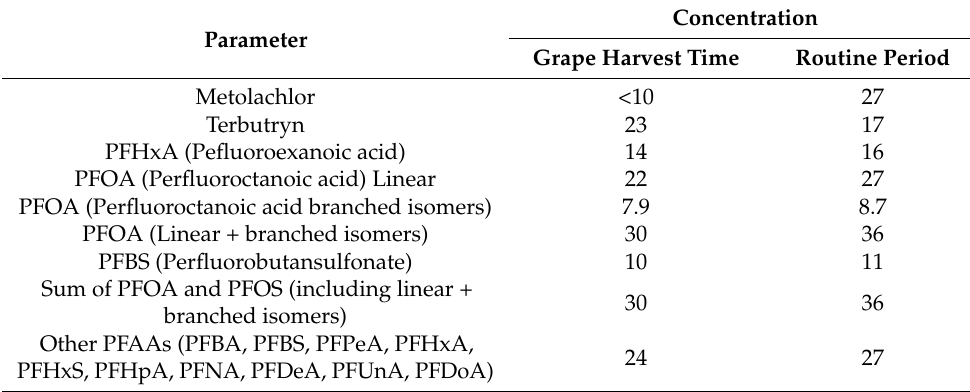
Table 10. Polynuclear aromatic hydrocarbons, perfluorinated alkyl substances, chlorinated insecti- cides and herbicides resulted above the respected detection limits in the effluent wastewater (average values, in ng/L). Concentration Parameter Grape Harvest Time Routine Period Metolachlor <10 27 Terbutryn 23 17 PFHxA (Pefluoroexanoic acid) 14 16 PFOA (Perfluoroctanoic acid) Linear 22 27 PFOA (Perfluoroctanoic acid branched isomers) 7.9 8.7 PFOA (Linear + branched isomers) 30 36 PFBS (Perfluorobutansulfonate) 10 branched